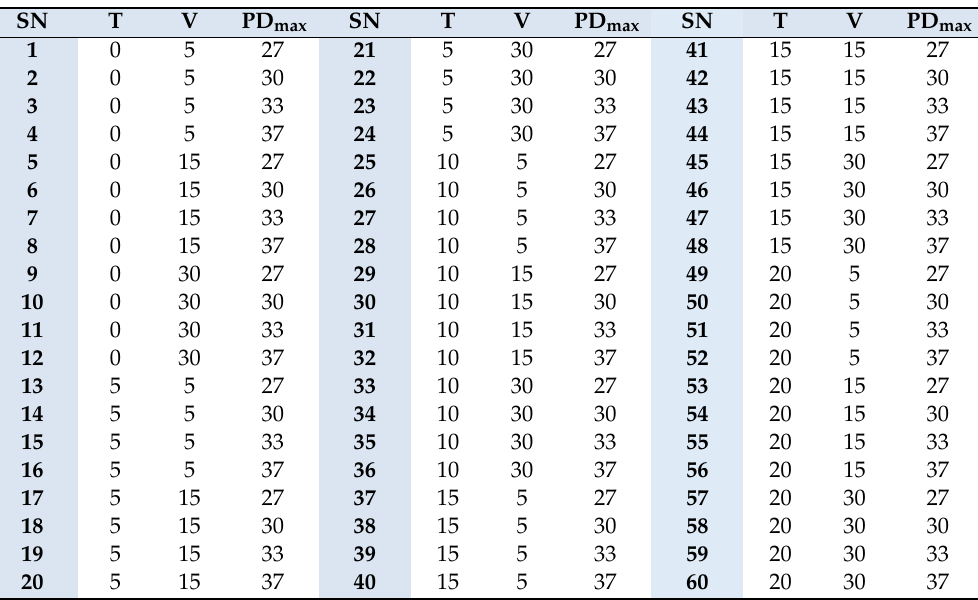
Table 4. Summary of the 60 simulation